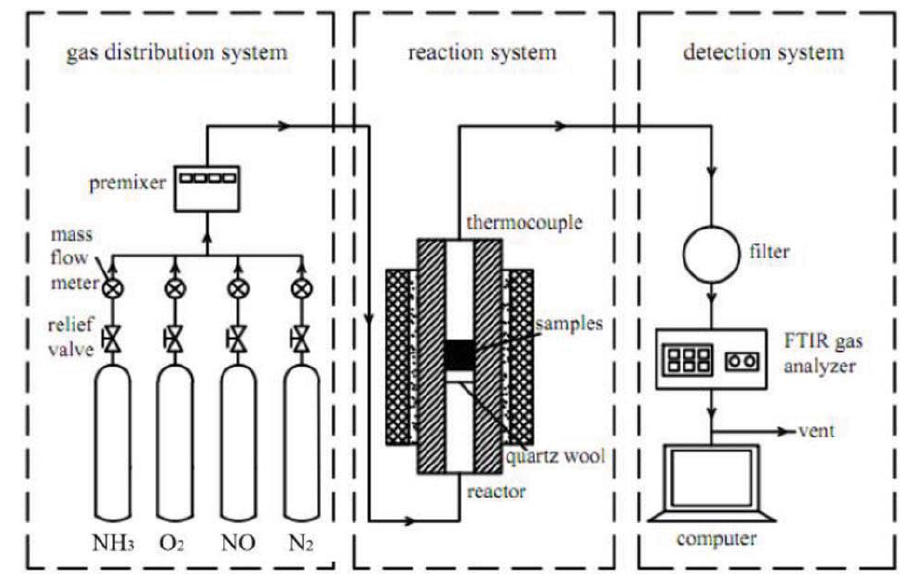
Figure 1: Reaction device